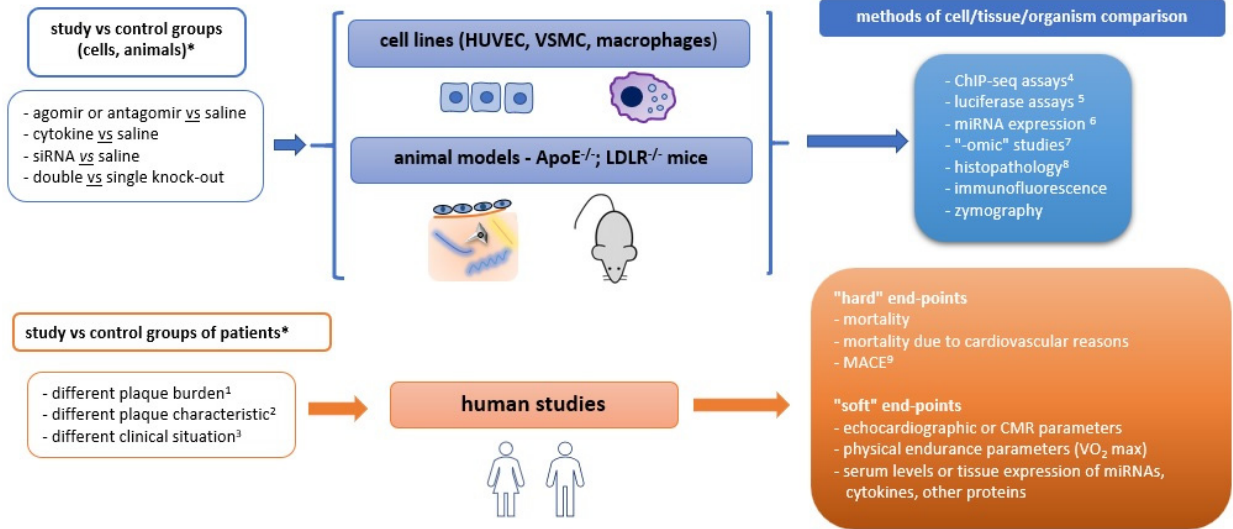
Figure 2. Methodological approaches in studies on atherosclerotic plaque development and progression: *—example studies; 1—assessed by computed tomography coronary angiography (CTCA), 2—assessed by intravascular ultrasound (IVUS) or positron emission tomography (PET); 3—for instance: chronic vs. acute coronary syndrome patients; 4—chromatin state assessment (ChIP—chromatin immunoprecipitation); 5—promoter and transcription factor assessment; 6—by microarray, next-generation sequencing (NGS) and quantitative real-time polymerase chain reaction (qRT-PCR); 7—systemic studies, i.e., genomic (genome-wide association study—GWAS), proteomic, transcriptomic, metabolomic; 8—hematoxylin-eosin staining, immunohistochemistry; 9—major adverse cardiovascular events (MACE), i.e., myocardial infarction, stroke, need for urgent revascularization. Other abbreviations: siRNA—small interfering RNA, HUVEC—human umbilical vein endothelial cell, miRNA—microRNA, CMR—cardiac magnetic resonance imaging, ApoE—apolipoprotein E, LDLR—low-density lipoprotein receptor, VO 2 max—maximum rate of oxygen consumption.